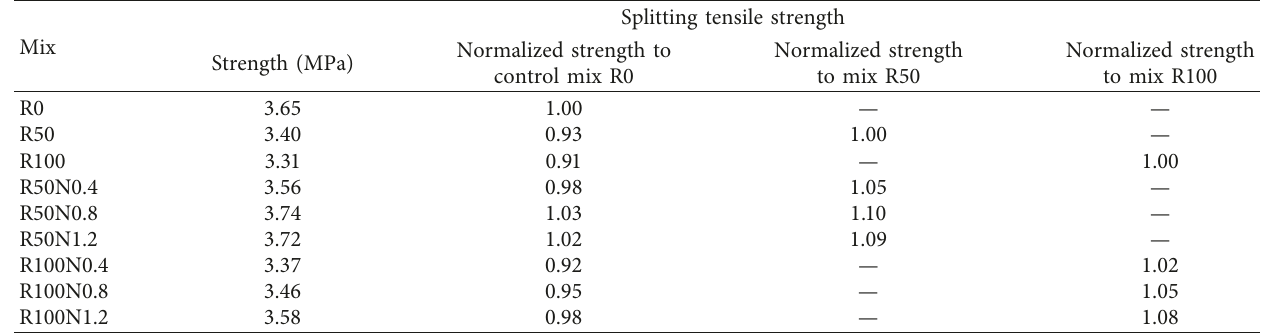
Table 4: Results of splitting tensile strength test.